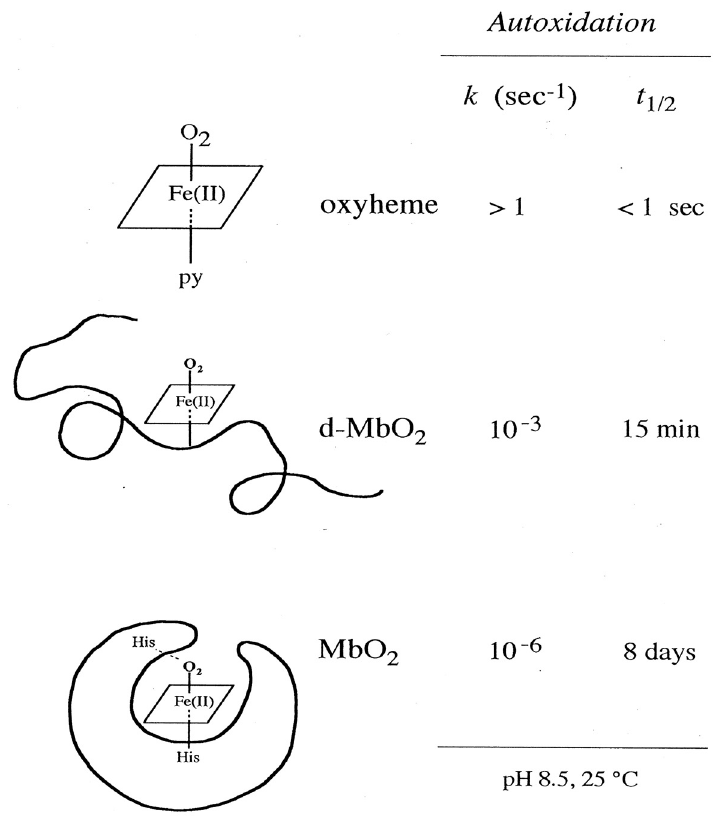
Figure 19. Roles of a globin moiety in Mb or Hb molecules, redrawn from Sugawara et al.